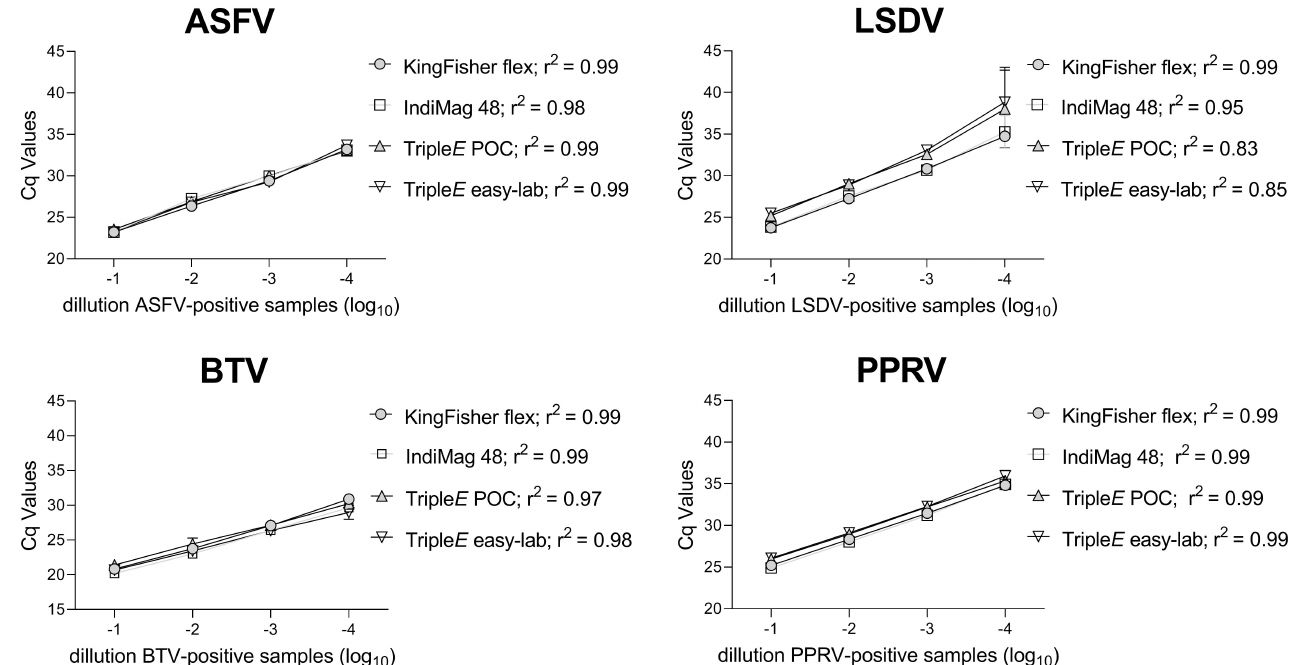
Figure 5. Linearity and analytical sensitivity of the four different extraction methods. The ASFV-, LSDV-, PPRV- and BTV-positive samples were diluted ten-fold. Extracted RNA or DNA was quantified as previously described. Regression lines are illustrated and the correlation coefficient given in the legend for each method. POC: